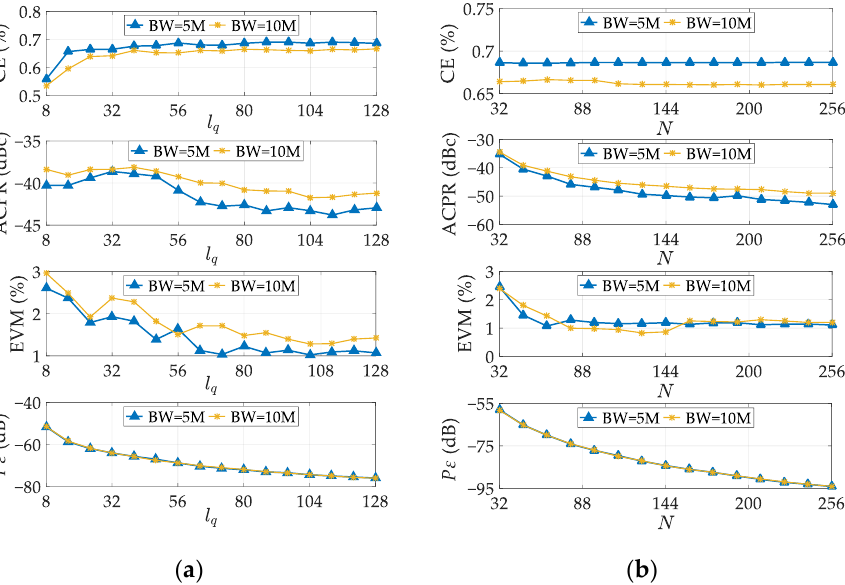
Figure 7. The effect of l q and N on the performance of the main modulation. ( a ) N = 64; ( b ) l q = 128.